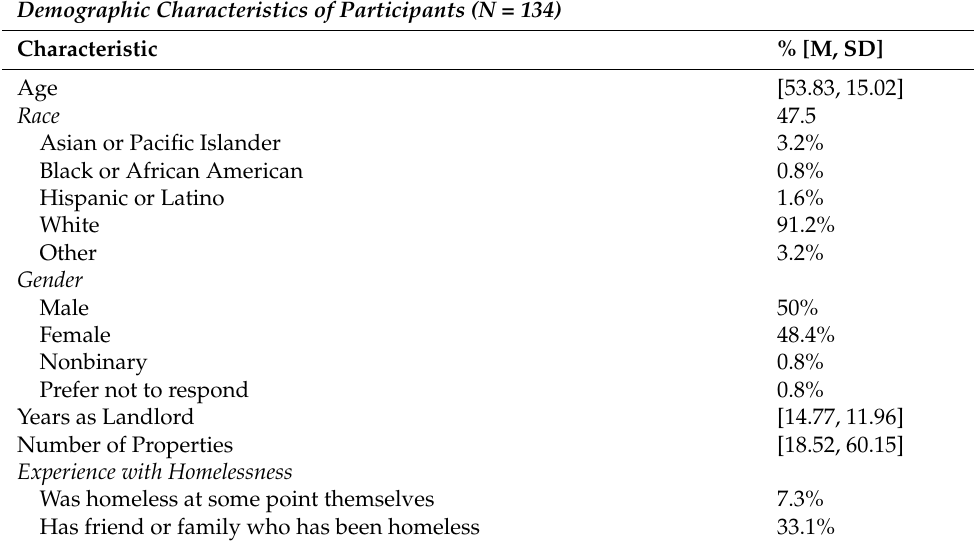
Table 1. Demographic characteristics of participants. This table provides the demographic character- istics of landlords who participated in the present